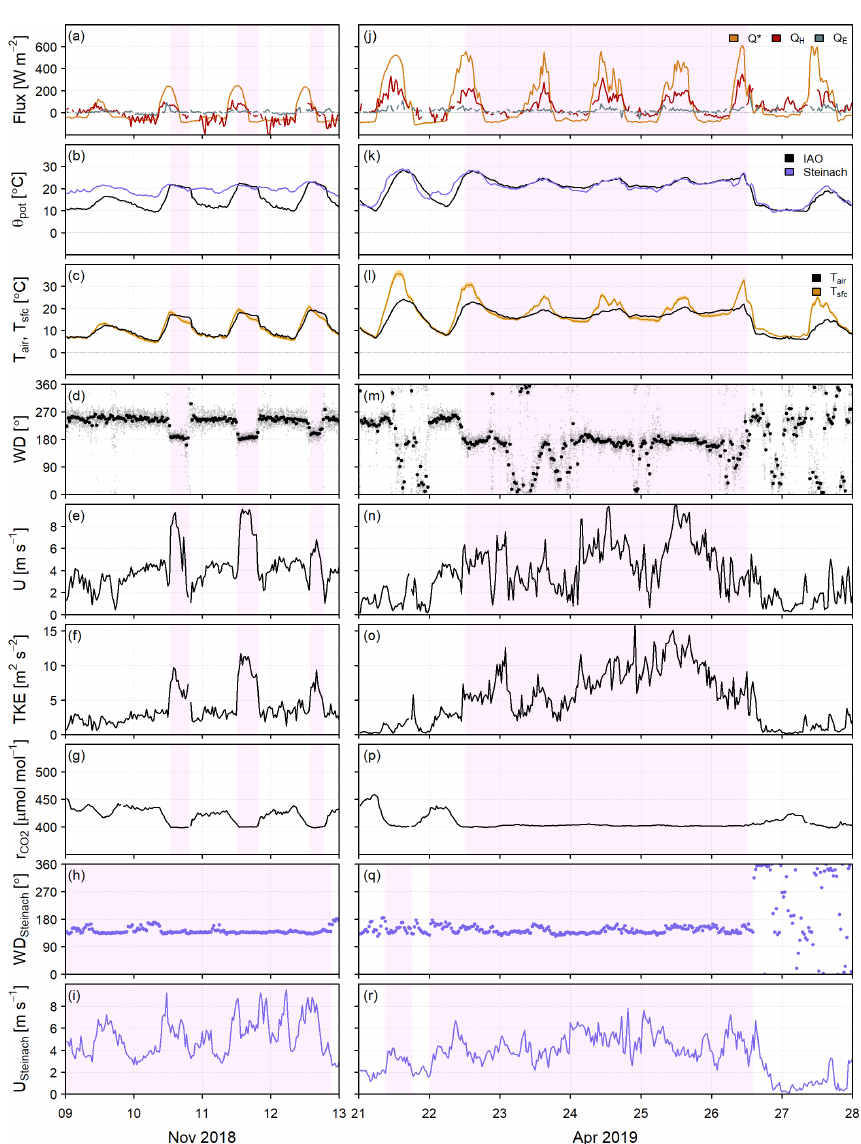
Figure 7. As in Fig. 6a–i for the periods (a–i) 9–13 November 2018 and (j–r) 21–28 April 2019. Data are shown for (a–g, j–p) IAO and (h–i, q–r)